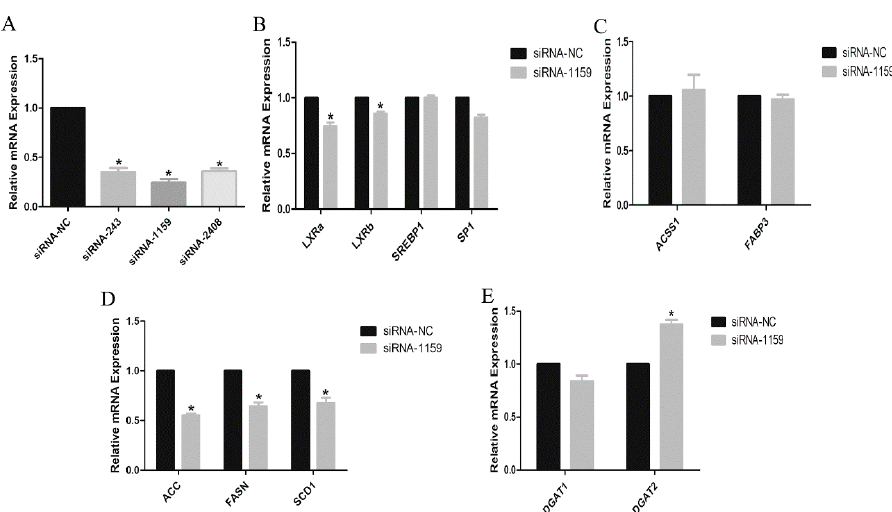
Figure 4. Effect of EGFR siRNA on genes related to lipid metabolism in GMECs. Control siRNA is negative control (siRNA-NC). ( A ) EGFR knockdown efficiency by siRNA was analyzed. ( B – E ) the expressions of lipogenic genes in EGFR knocked-down GMECs were investigated. Values are presented as means ± SD of three independent experiments. * Means p < 0.05.